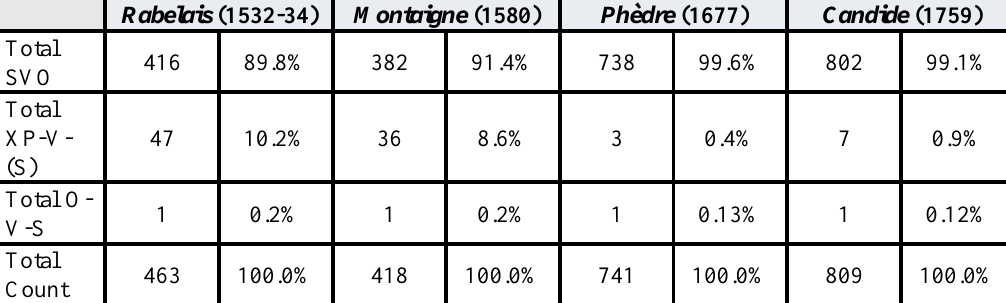
Table 1. Constituent Fronting in Renaissance and Classical